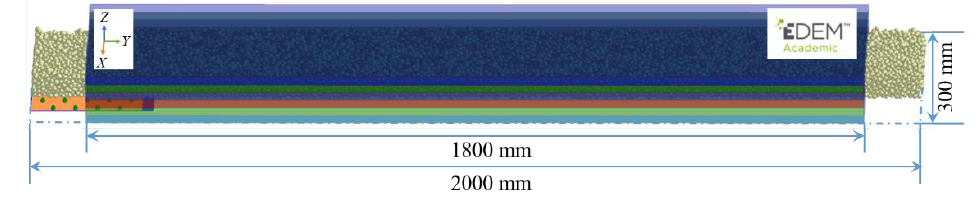
Figure 9. Original particle bed.